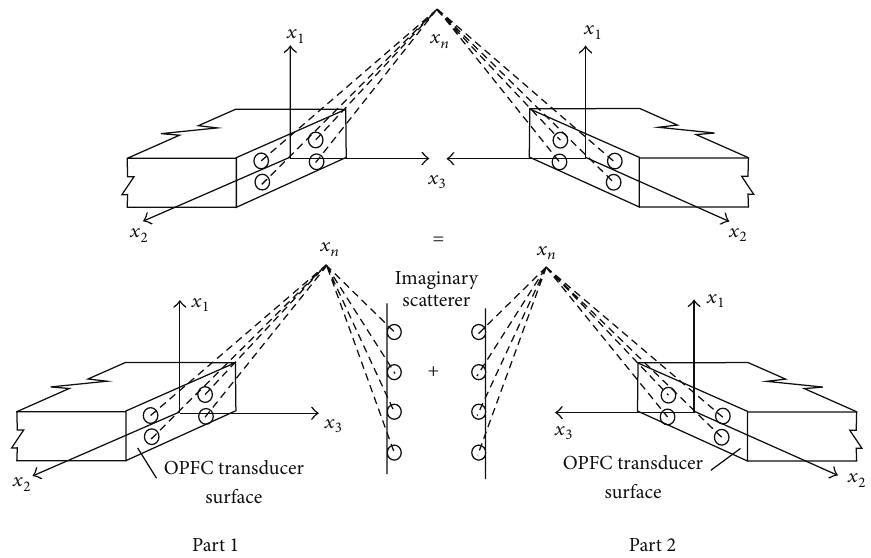
Figure 2: The interaction effects of two transducers by superimposing two